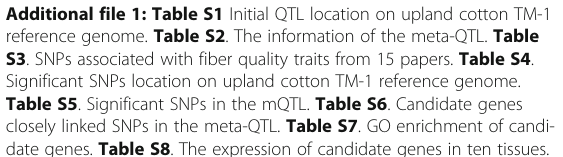
Table S5 . Significant SNPs in the mQTL. Table S6 . Candidate genes closely linked SNPs in the meta-QTL. Table S7 . GO enrichment of candi- date genes. Table S8 . The expression of candidate genes in ten tissues.